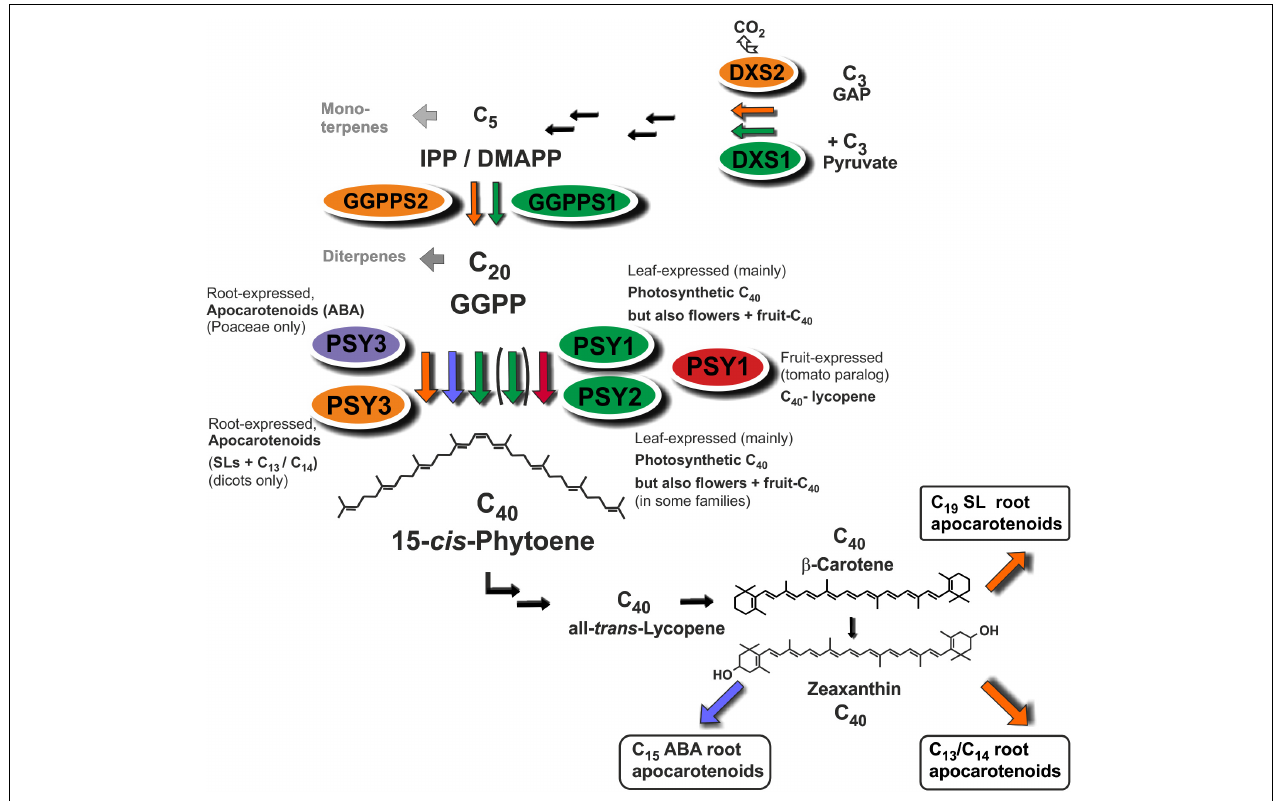
FIGURE 8 | Roles of diversified PSY isoforms in carotenoid and apocarotenoid biosynthesis. PSY1 and PSY2 isoforms (marked in green and red) appear to be mainly involved in C 40 carotenoid biosynthesis in leaves, flowers, and fruits. Two different types of PSY3 isoforms may be committed to integrative carotenoid/apocarotenoid biosynthesis in roots toward formation of boxed products such as ABA (PSY3 of Poaceae, marked in blue) or SL and C 13 /C 14 apocarotenoids (PSY3 of dicots, marked in orange). Isoforms at upstream steps (DXS, GGPPS) are coregulated with PSY1/PSY2 (green background, DXS1, GGPPS1) or PSY3 of dicots (orange background, DXS2, GGPPS2) potentially forming separate product-oriented metabolons with the respective PSY